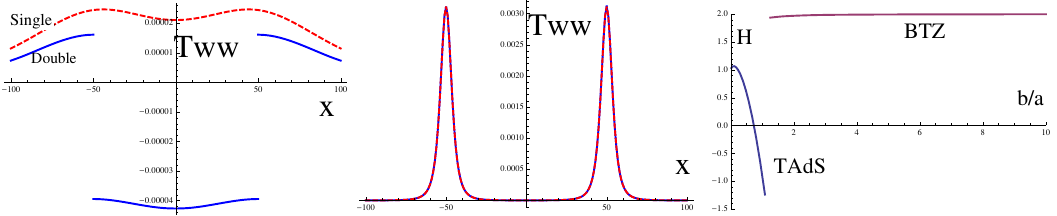
Figure 35 . The behaviors of energy stress tensor T ww in a holographic CFT under double splitting quenches at the time t = 0. The left and middle graph describes the energy stress tensor as a function of the position x with the quench parameter a = 6 : 3 (BTZ phase) and a = 76 : 3 (Thermal AdS phase), respectively (we always set b = 50). The blue graph describes T D , while the red ww dotted one shows T S ( x = b ) ww + T S ( x = (cid:0) b ) ww . The right picture is a plot of the function H ( b=a ) as a function of b=a . Note that there is a phase transition at b=a = r 1 : (cid:3) ’